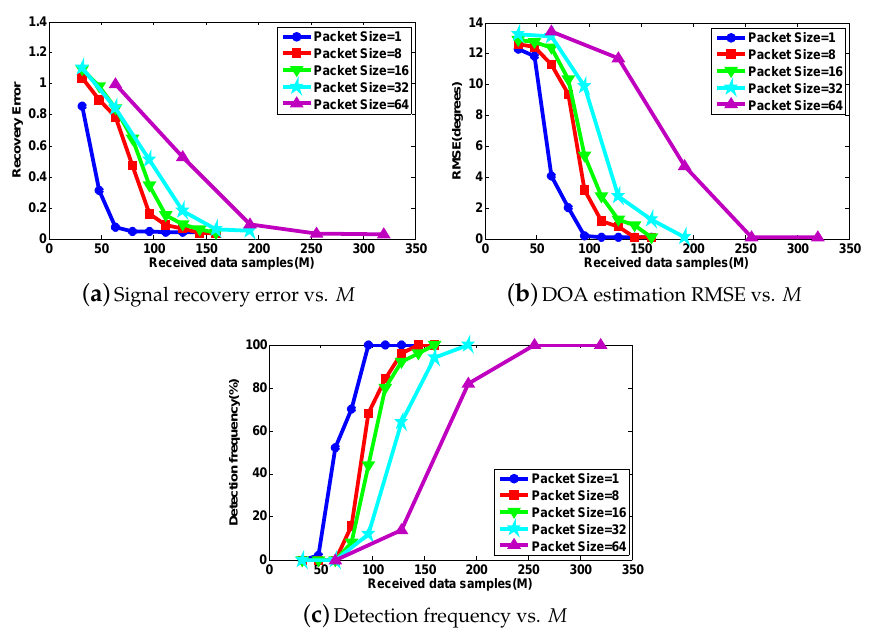
Figure 9. The signal recovery error, DOA estimation RMSE and detection frequency versus the number of received data samples M under different packet sizes when projection (active CS) is not introduced at each array sensor.